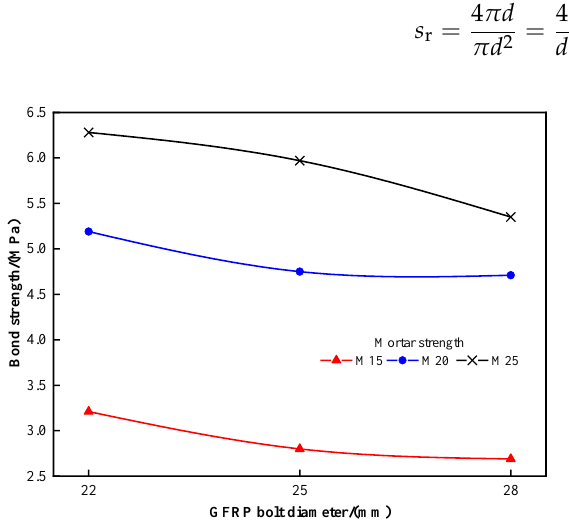
Figure 3. Relationship between bond strength and reinforcement diameter.